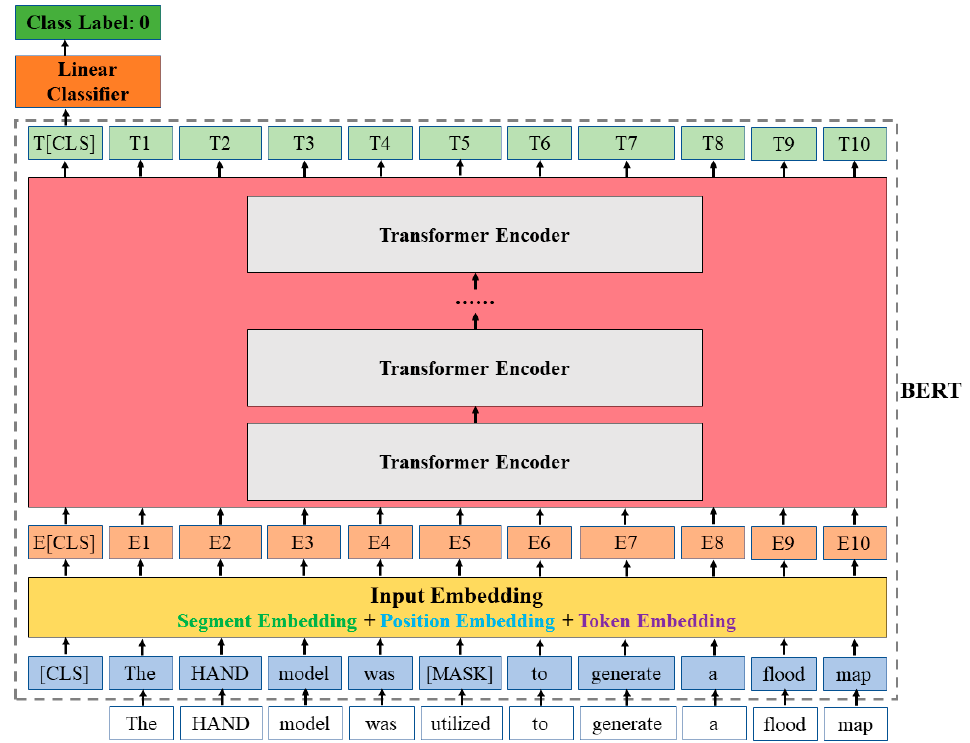
Figure 3. Illustrations of BERT on a single sentence classifier task. The main parameters were set as follows: batch size = 32, epochs = 20, learning rate = 5 × 10 − 5 , and hidden size =